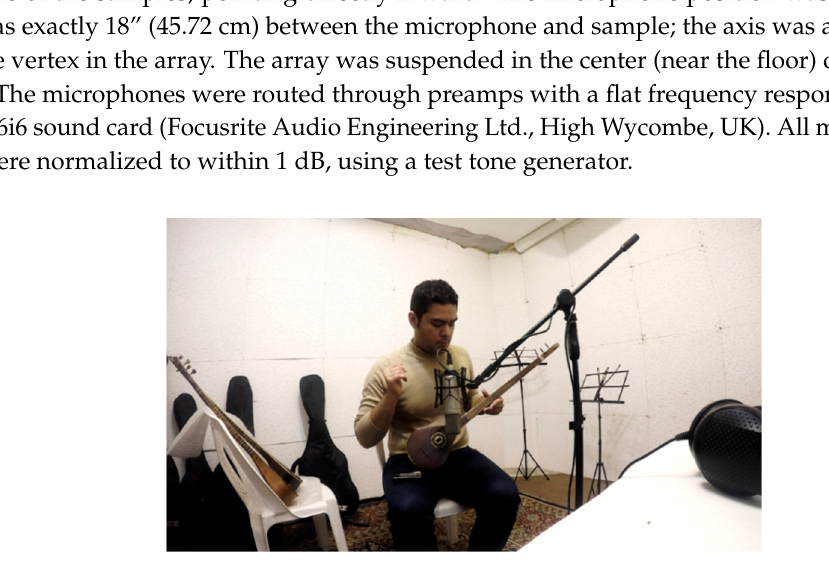
Figure 12. Experimental Apparatus.